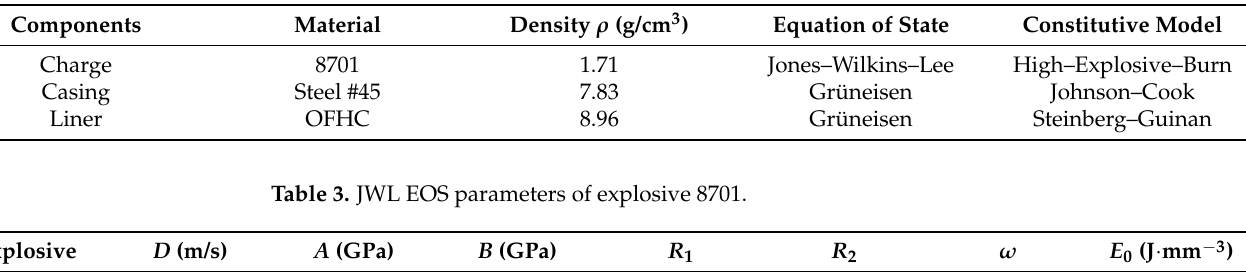
Table 2. Material models used in numerical simulation.